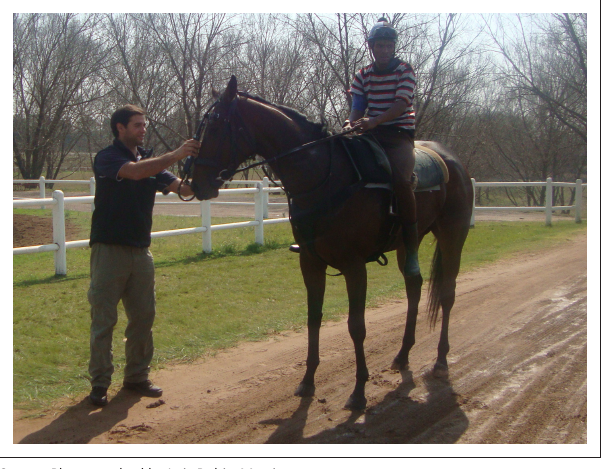
FIGURE 1: Placement of the endoscope at the racetrack.